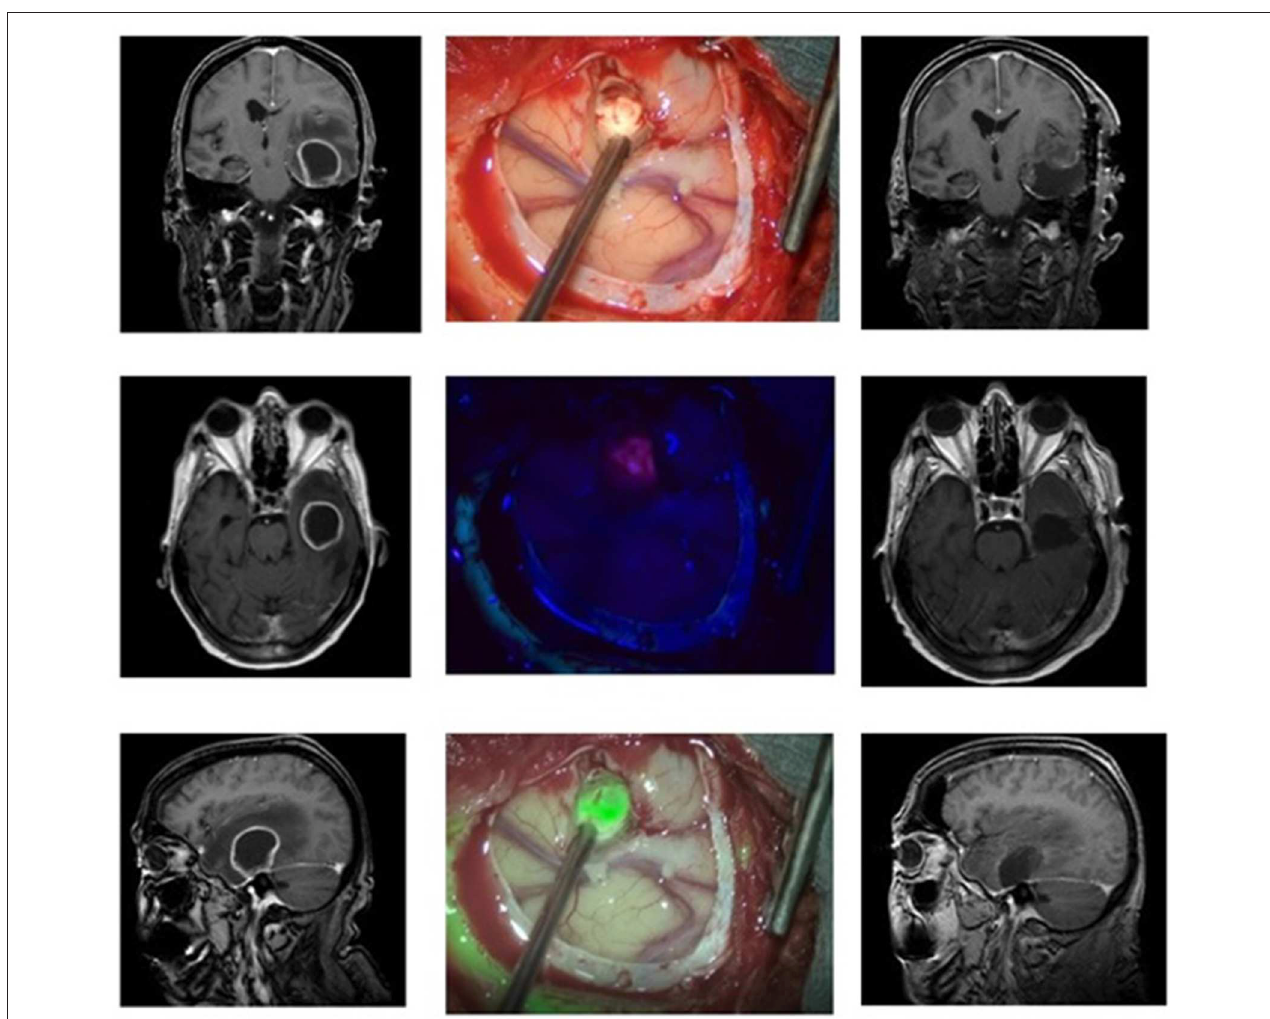
FIGURE 3 | Metastasis from a squamous tongue carcinoma in a 78 old patient. Preoperative (left side) and postoperative MRIs (right side) showing the lesion and the total resection zone, respectively. In the middle column, the operative cavity is seen. The top picture shows the exposed tumor under white light, below it under blue light with pink nuances, and at the bottom the fusion of both images in the MFL-mode (“green” is the tumor in pseudo-color